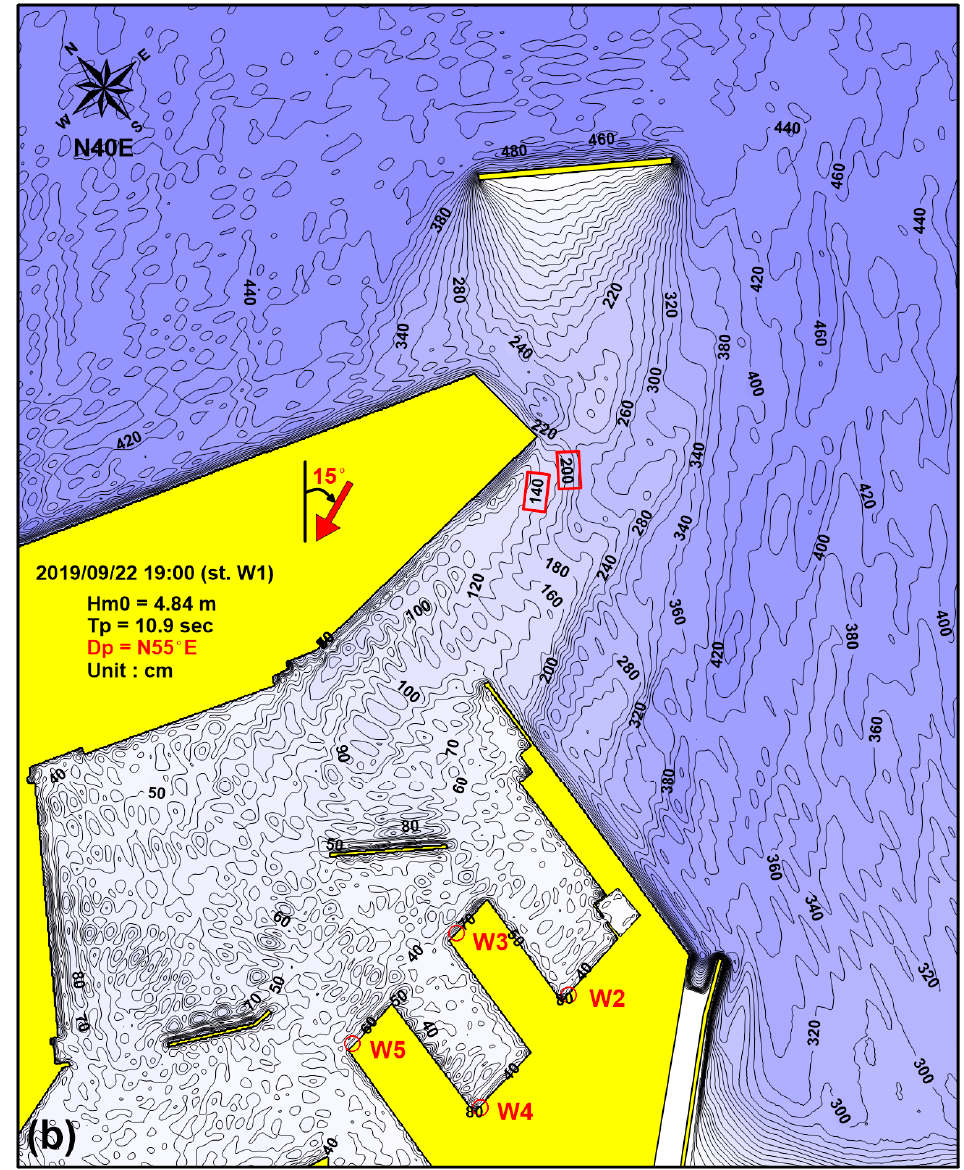
Figure 19. ( a ) Contours of wave height isolines in the case of AC. The model conditions were the same with those in Figure 17, except that D p , the input wave direction along the outer open boundary, was set as N15.0 ◦ E as an example of extreme conditions that represented NNE waves; ( b ) the same as ( a ), except that D p was set as N55.0 ◦ E as an example of extreme conditions that represented NE waves. In the case of the extreme NE waves (N55.0 ◦ E), the waves could enter into the port easily compared to the case of N15.0 ◦ E. When compared to the results in BC (Figure 18), wave